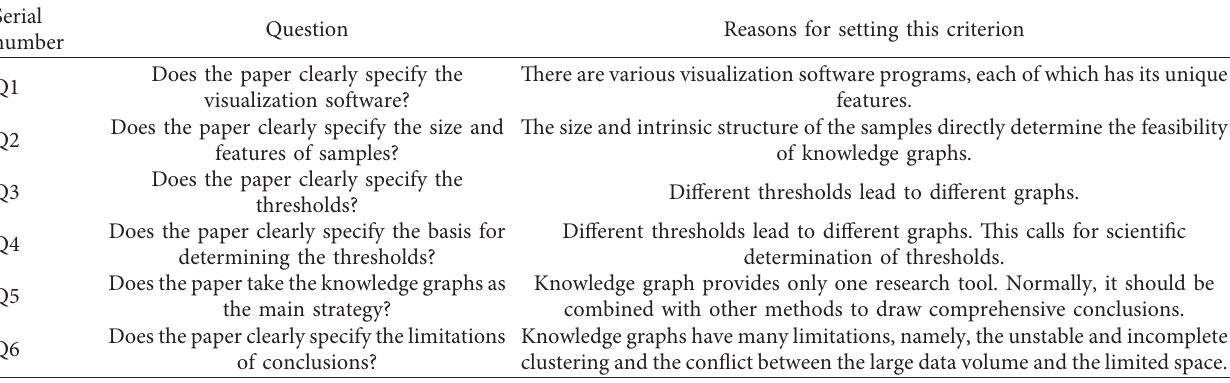
Table 5: Evaluation criteria and questions.